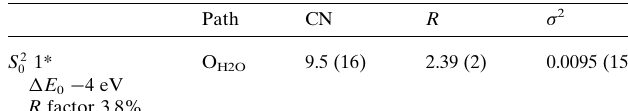
Table 3 Parameters from Np IV EXAFS fits. Asterisks (*) indicate fixed parameters.